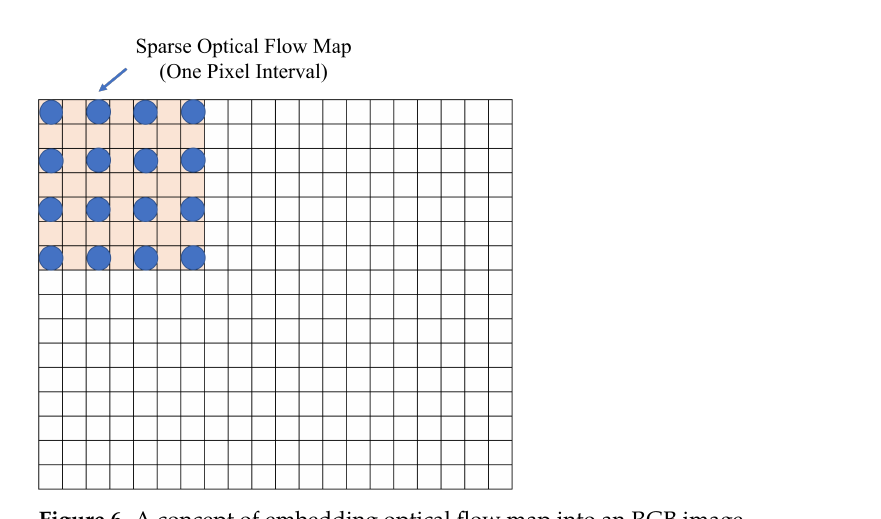
Figure 6. A concept of embedding optical flow map into an RGB image. The luminance of red, green, and blue towards gray scale luminance is corresponded as shown in Figure 7.